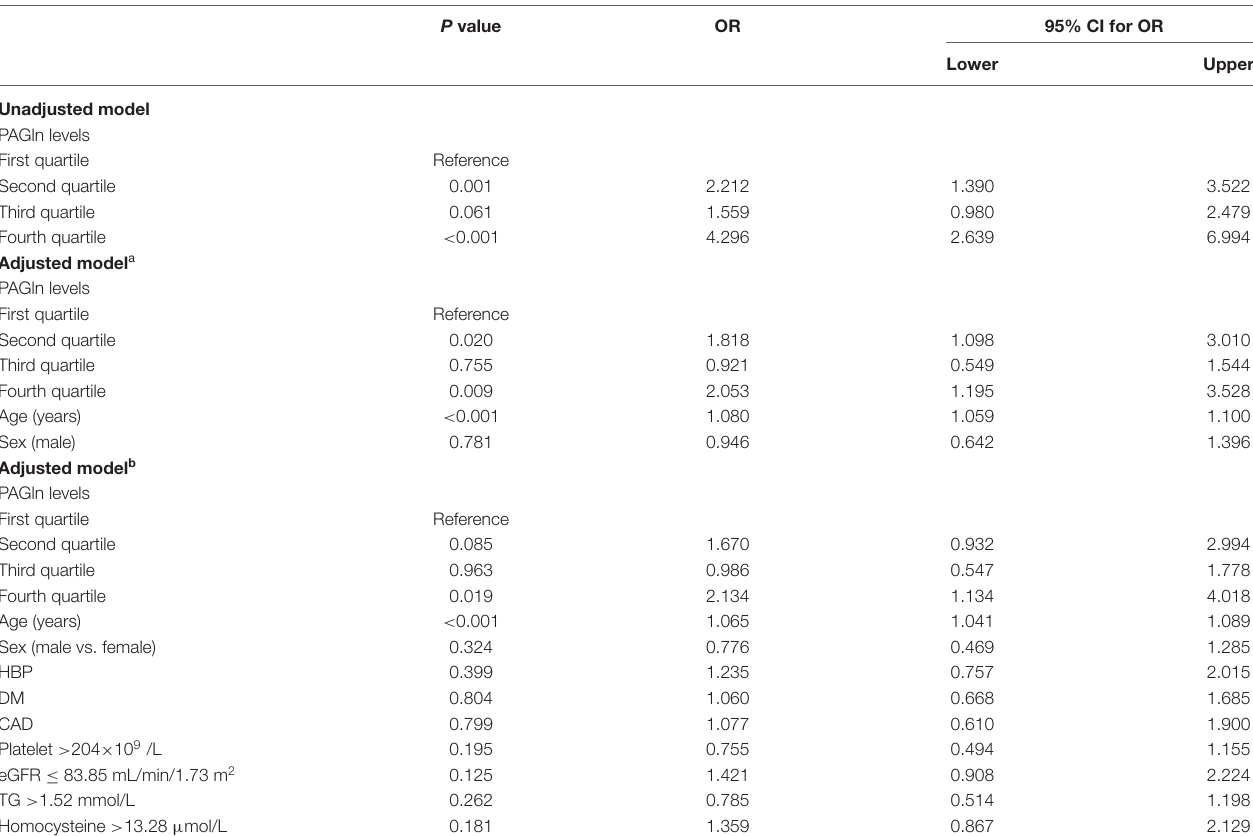
TABLE 3 | Logistic regression analyses of the association between PAGln levels and overall WMH. P value OR 95% CI for